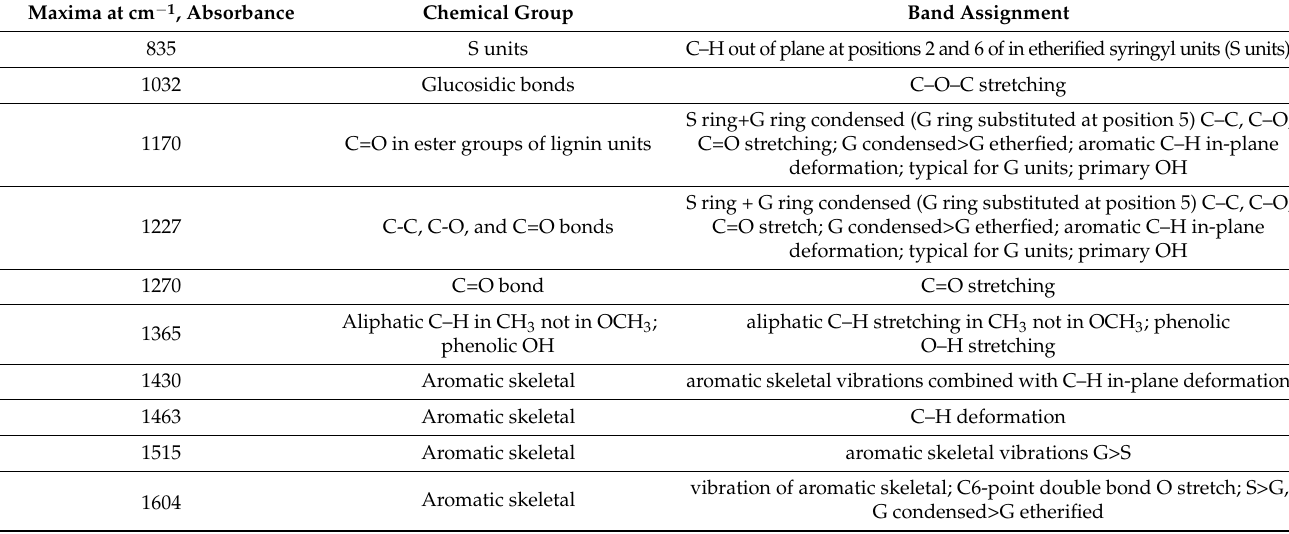
Figure 6. The FTIR spectra of membrane foulant. Table 5. Peak assignment of FTIR spectra of membrane foulant.